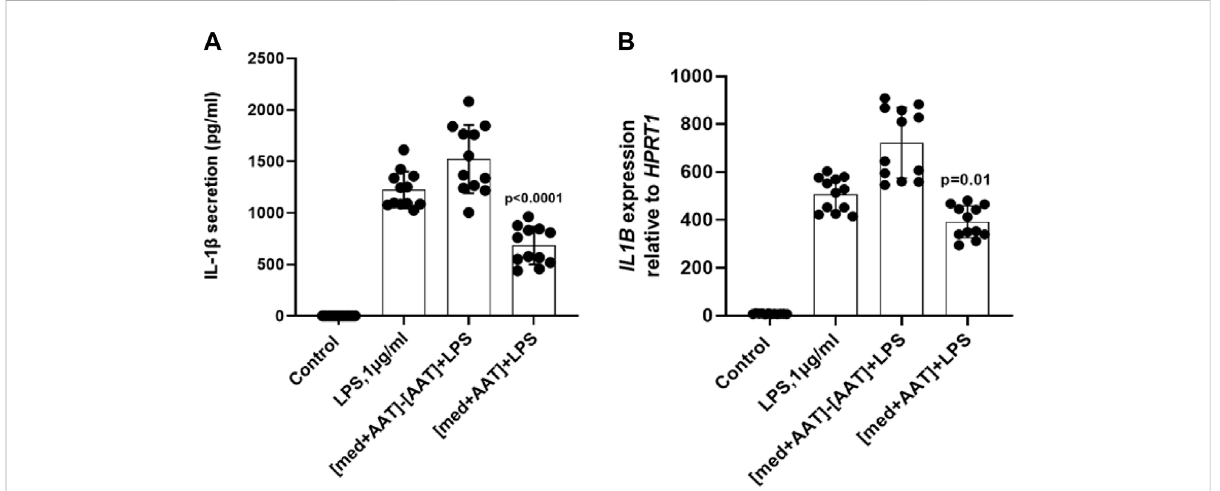
FIGURE 6 Total PBMCs when cultured in medium containing AAT (Zemaira ® ) show lower IL-1 β release and expression in response to LPS. LPS- inducedIL-1 β secretion (A) and IL1B mRNA expression (B) in total human PBMCs cultured for 6 h in basal medium pre-incubated for 30 min at 37 ° C, 5% CO 2 , alone or with 4 mg/ml AAT (Zemaira ® ) and added to the cells without [med + AAT] or with fi ltration through 3 kDa centrifugal fi lters [med + AAT] − [AAT]. Each bar represents the mean (SD) from three to fi ve experiments with independent donors, two repeats for